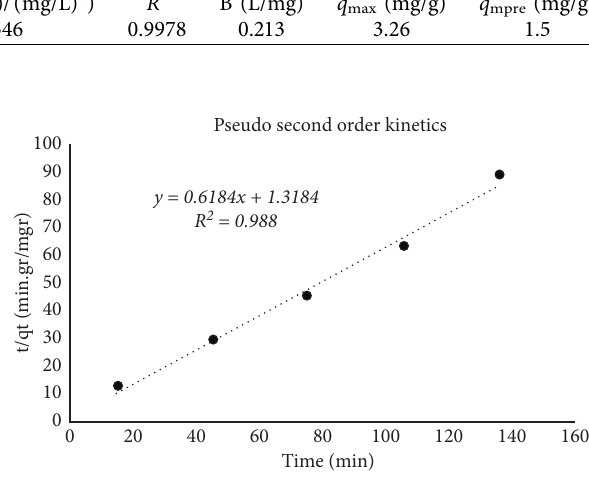
Figure 11: Pseudo-first-order kinetic for MG powder. Figure 12: Pseudo-second-order kinetic for MG